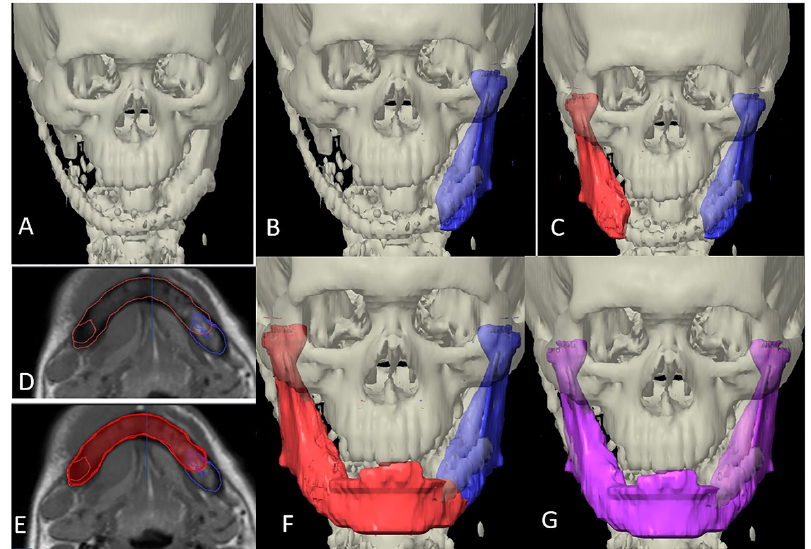
Figure 3. Designing template in category II. ( A ) 3-dimensional view of defect. ( B ) Segmentation of the remaining mandible on the left side. (blue color) ( C ) Mirroring to the right side. (red color) ( D ) Superimposing the current CT scan axial view to previous MRI. ( E ) Drawing the residual defect (red). ( F ) 3-dimensional view of virtually reconstructed defect (red). ( G ) Merging the segmented part, mirrored part and drawn part to form whole simulated mandible for printing. (purple color)